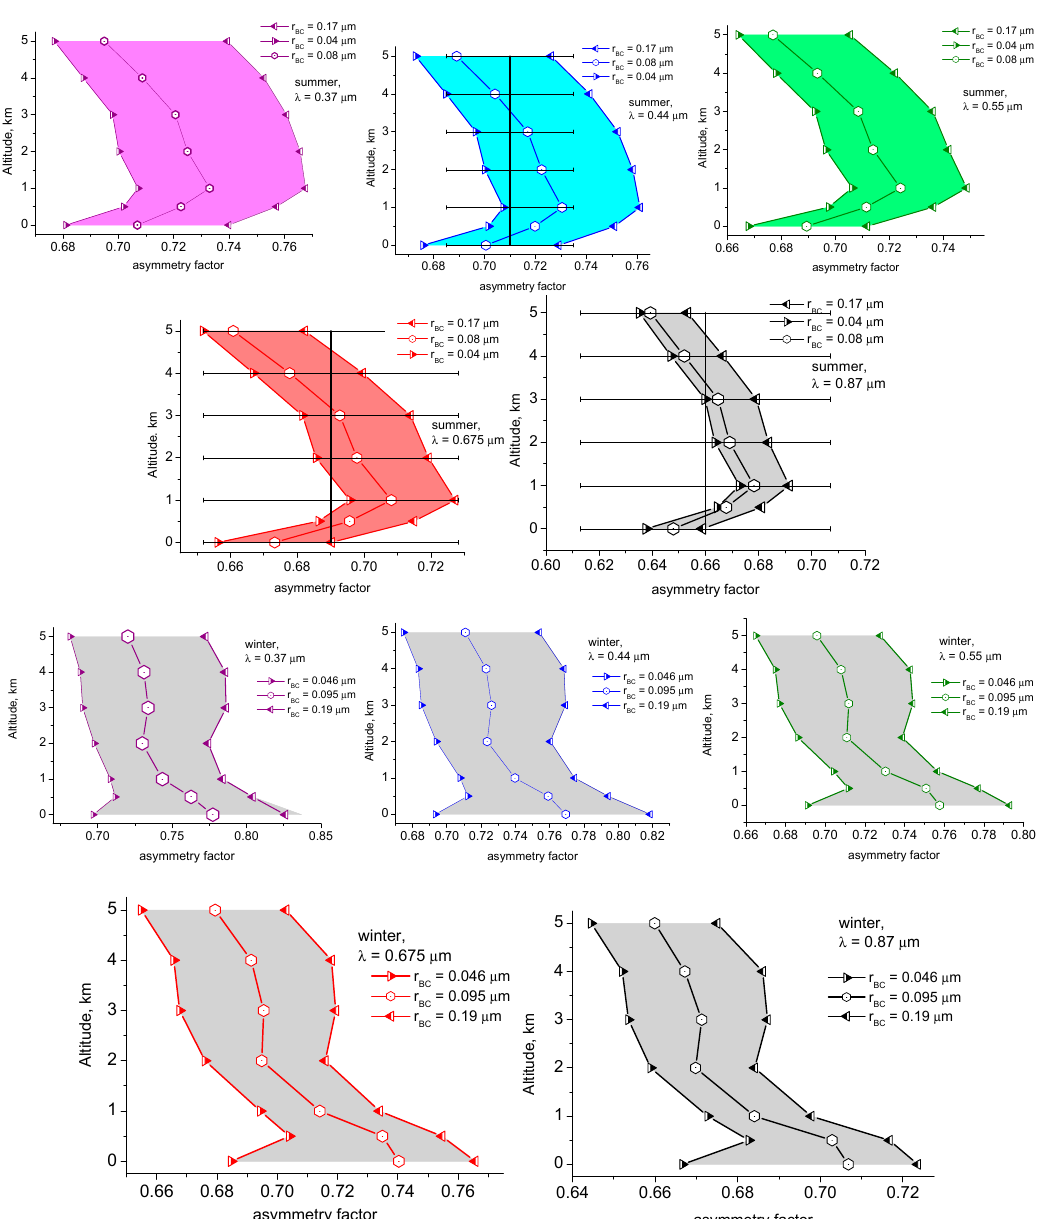
Figure 7. Vertical profiles of the asymmetry factor in summer and winter at different wavelengths at different median radii of the absorbing substance size distribution.